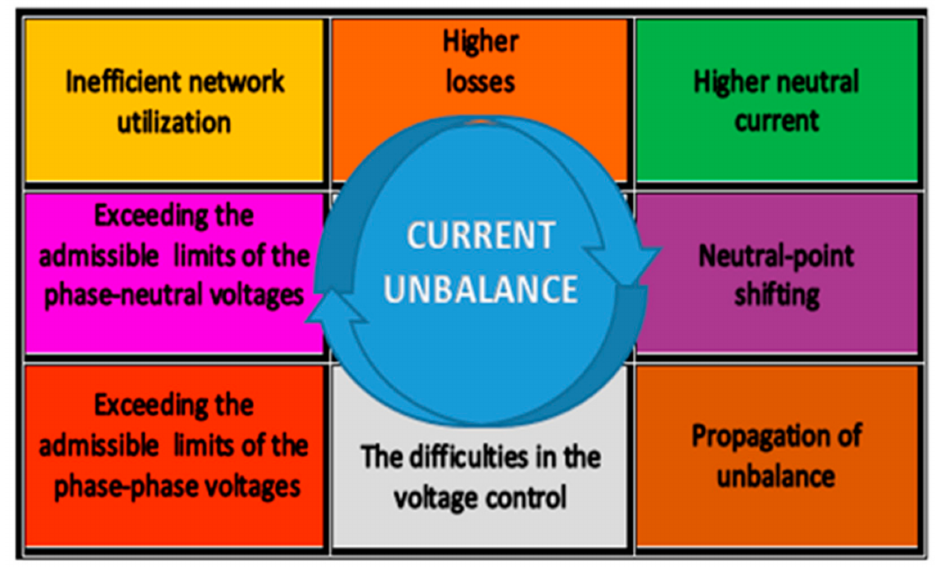
Figure 2. The effects of the current